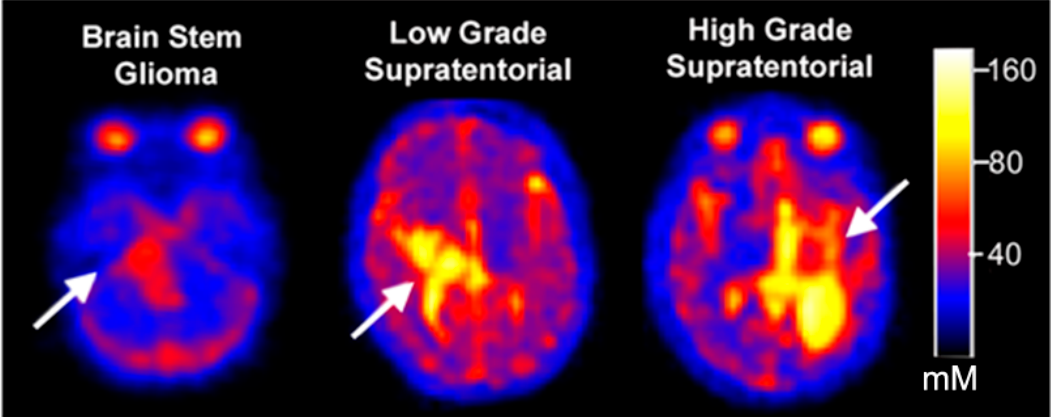
Figure 2. Sodium MRI images demonstrating relative total sodium concentration (TSC) between three different types of pediatric gliomas. There is reduced relative TSC in the pediatric diffuse intrinsic pontine glioma (DIPG) compared to the supratentorial low-grade and high-grade gliomas. There is no difference in relatively high TSC between the low-grade and high-grade gliomas (arrows point to the tumors).